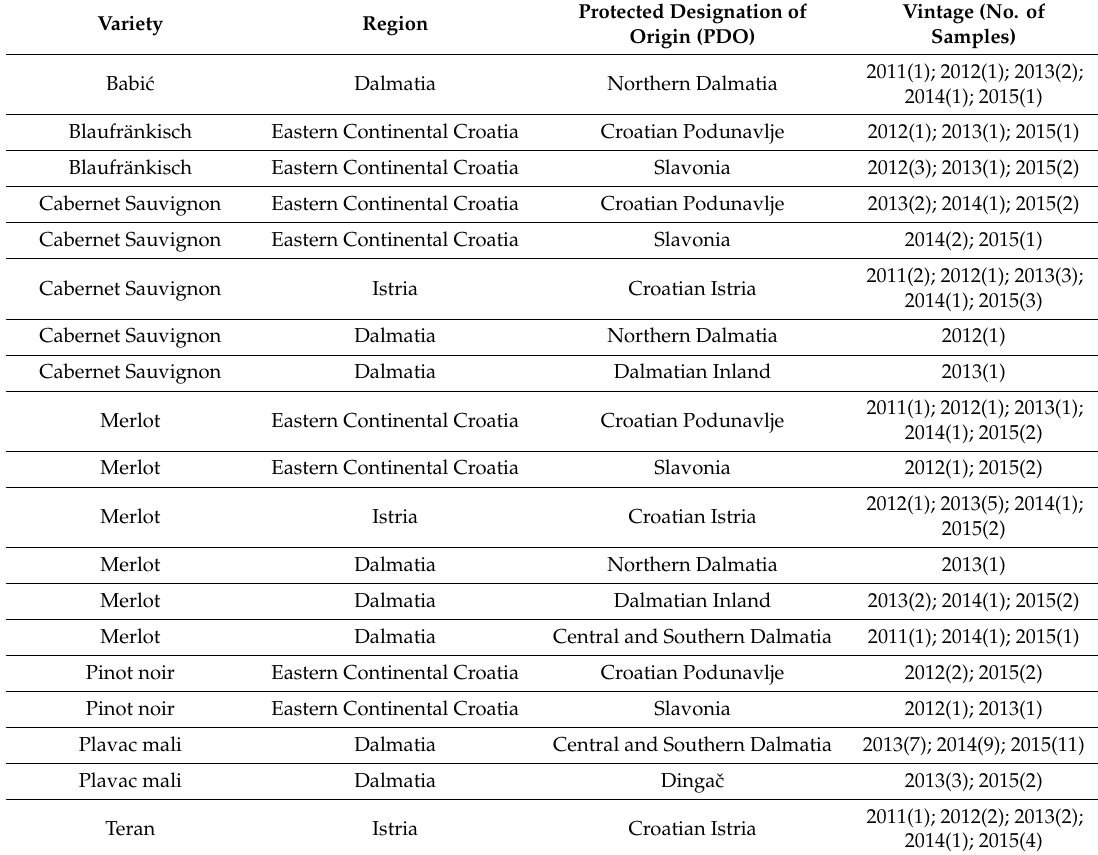
Table 1. Classification of wine samples according to variety, geographic origin and vintage. Variety